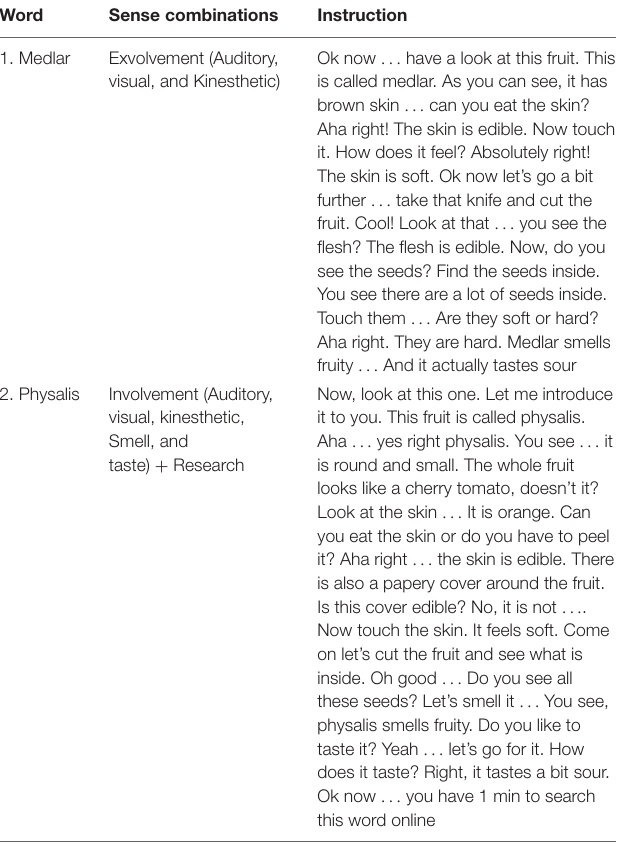
TABLE 3 | A Sample